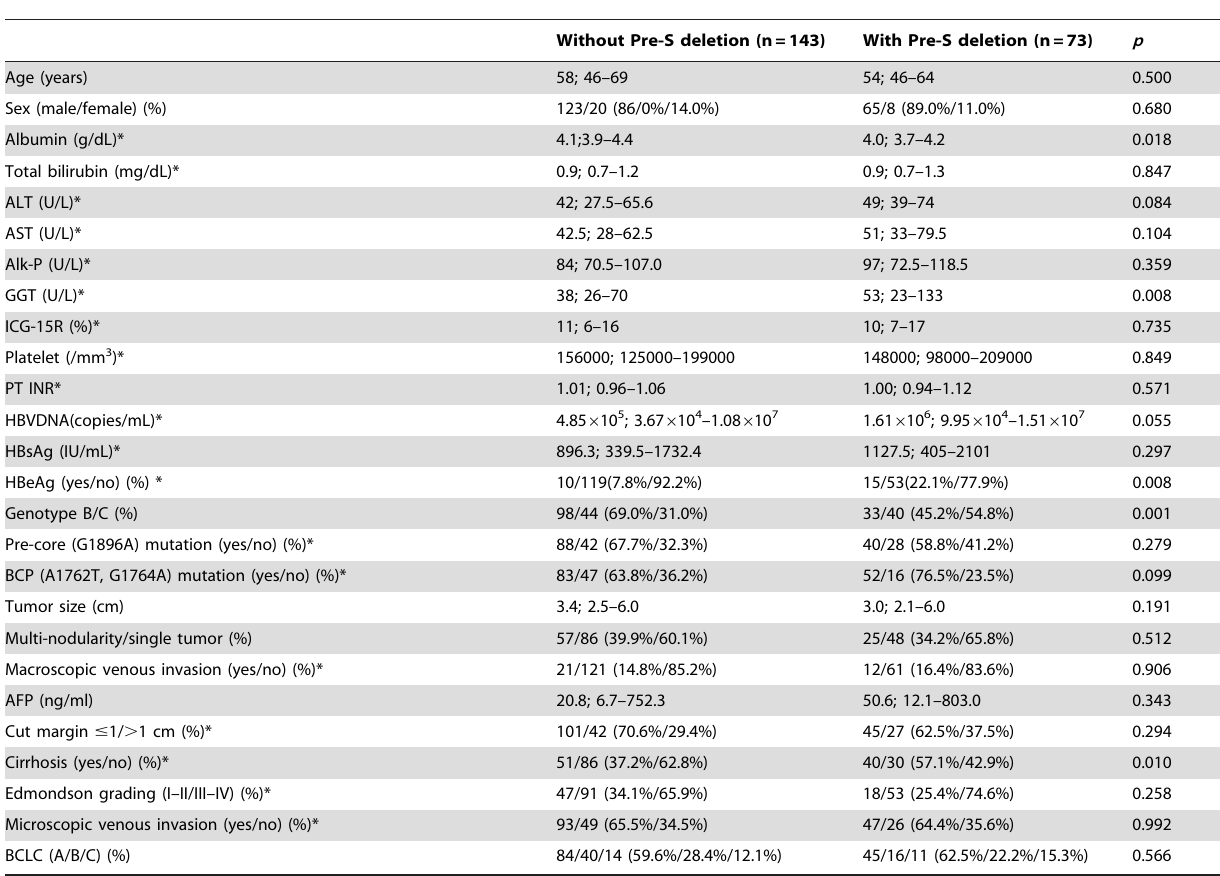
Table 3. Comparison of HCC patients with and without the pre-S deletion mutants of HBV.